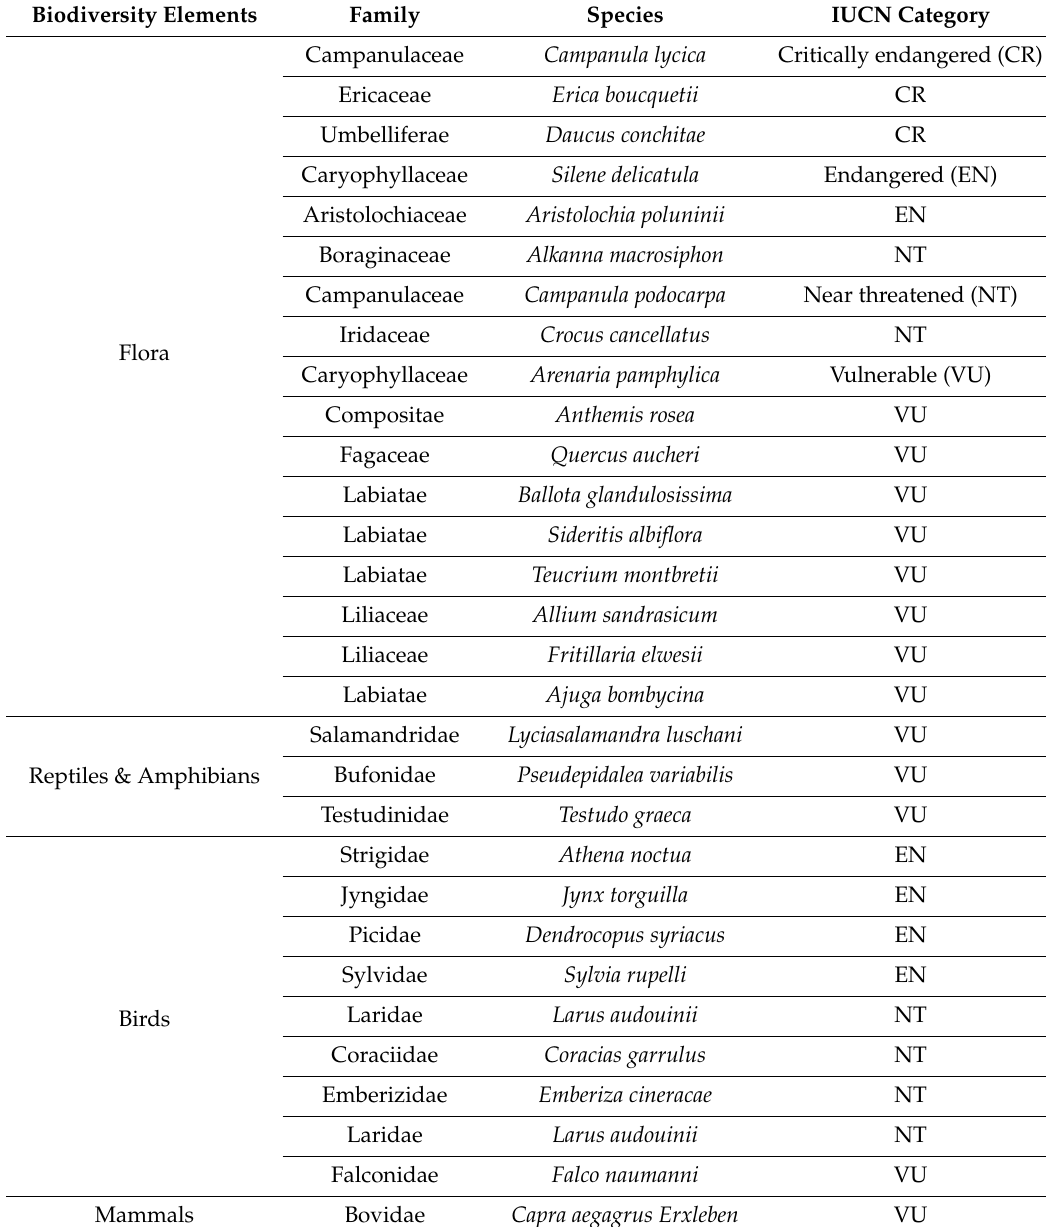
Table 1. List of endemic flora species which had their coordinates collected using global positioning system (GPS) in field works